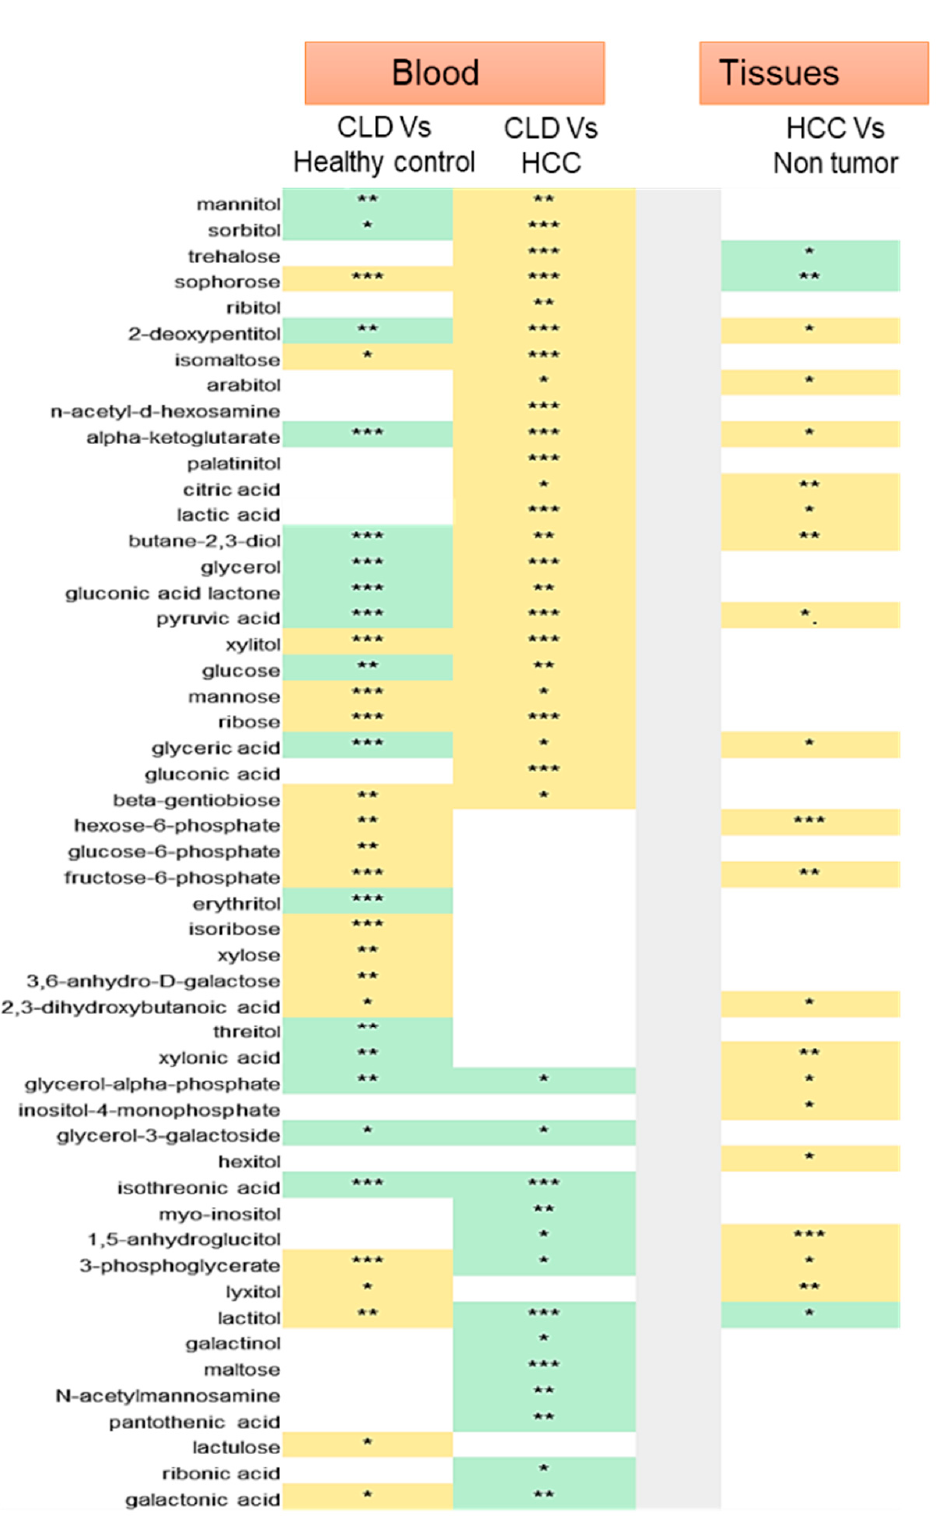
Figure 5. Sugar alcohols and carbohydrate metabolites in Chronic Liver Disease (CLD) and HCC. Heatmap indicating significant differences in blood of CLD versus healthy control (CLD versus healthy controls), HCC versus CLD (HCC Vs CLD) and HCC tissues versus its paired non- malignant hepatic tissues. Non-significant comparisons are left blank. Significant up-regulation yellow, down- regulation green. Stars give significance levels (*** p < 0.001, ** p < 0.01, * p < 0.05). Details in Supplementary S1 and S2.